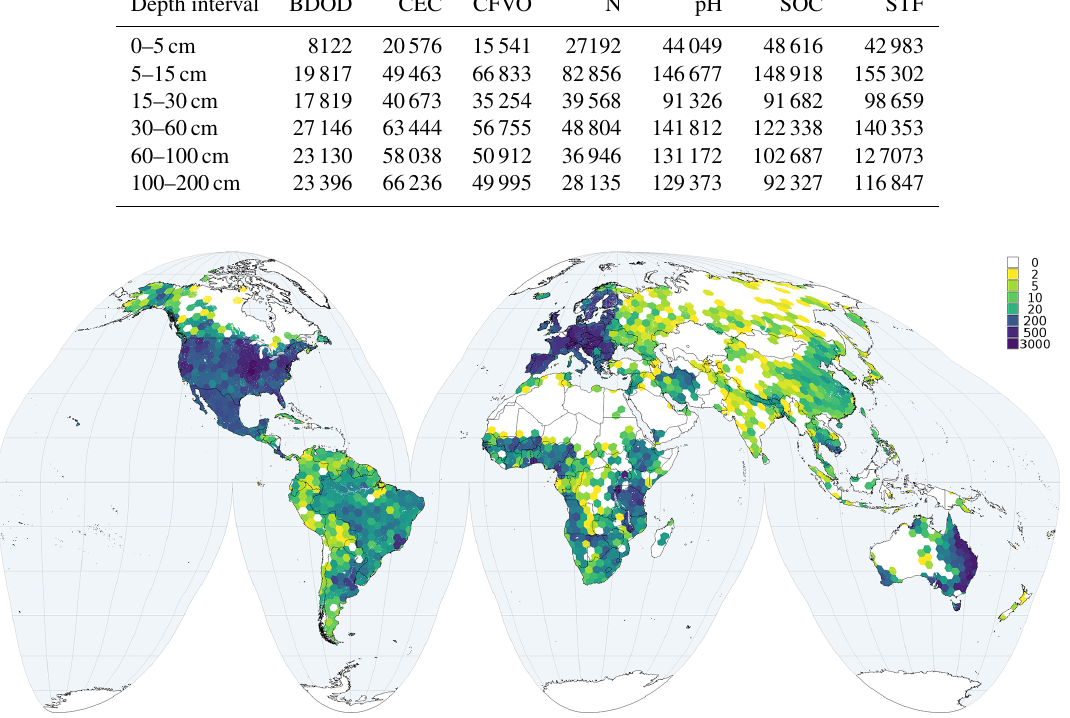
Figure 3. Number of observations per grid cell (70000km 2 ) for soil pH water .